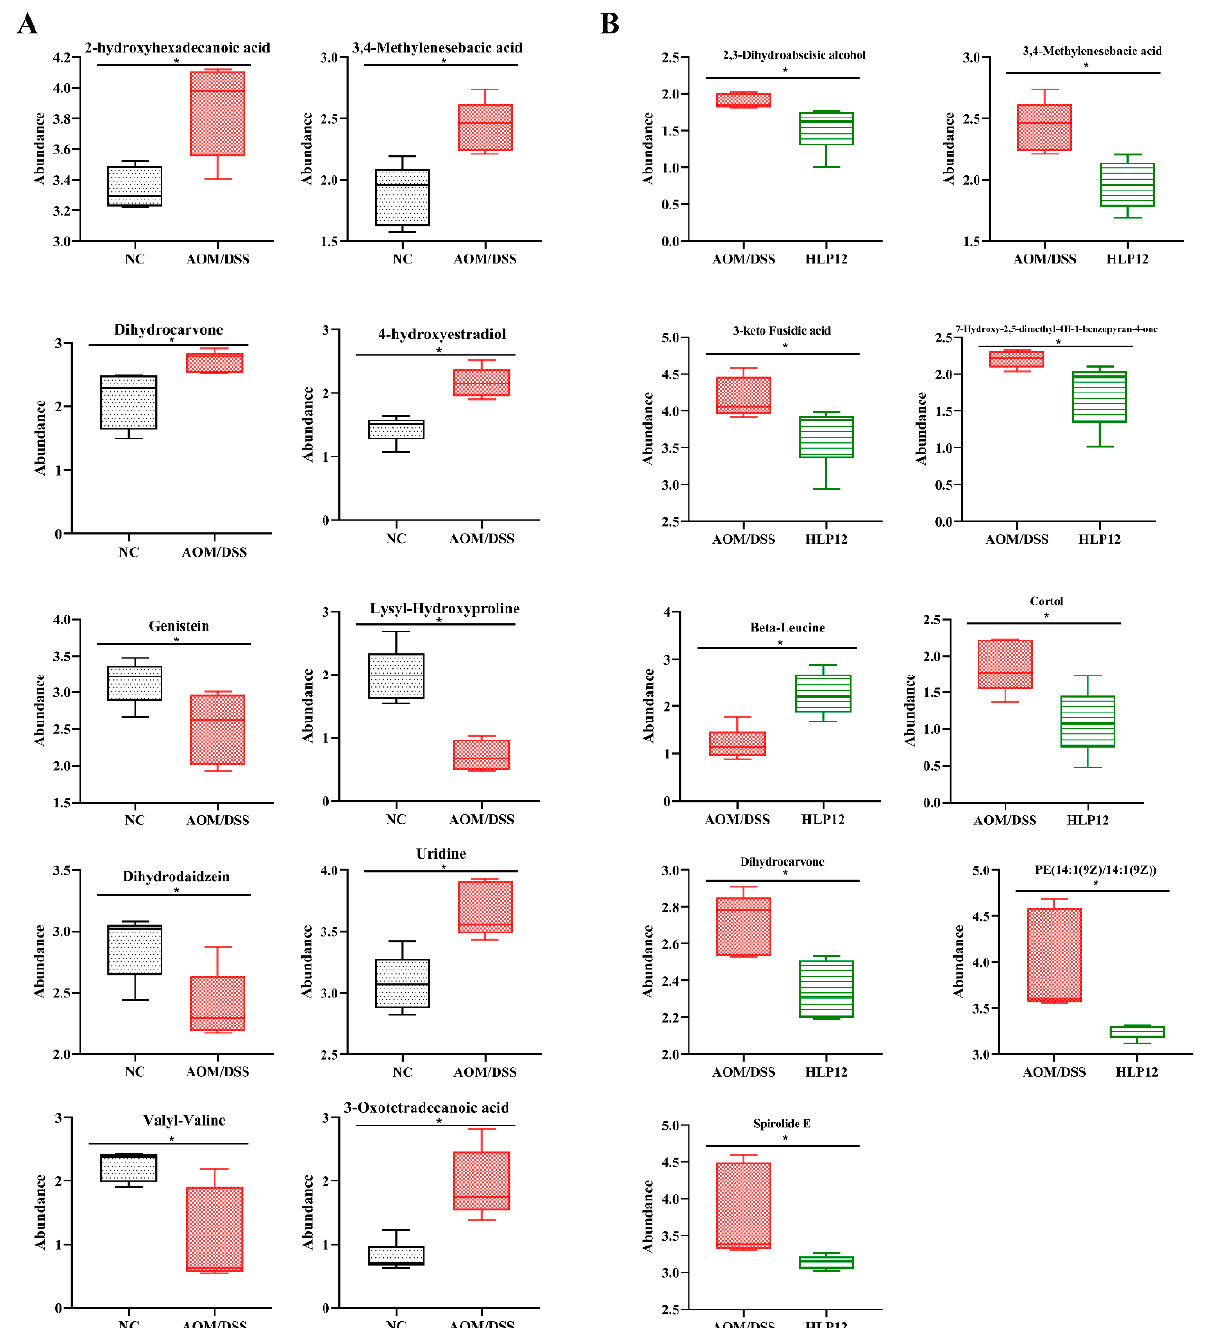
Figure 11. Untargeted fecal metabolomics analysis of AOM/DSS-treated mice ( n = 5). PCA score plot under negative ion mode ( A ) and positive ion mode ( B ).